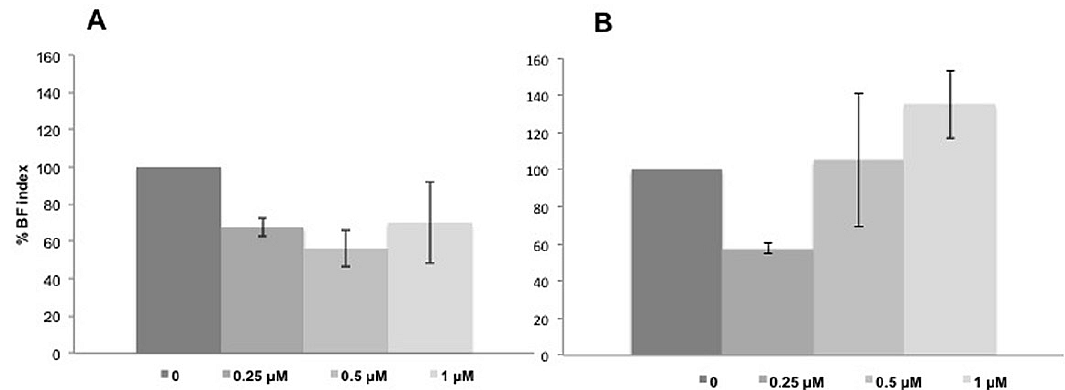
Figure 5. Biofilm (BF) production of KpTs101 in the presence of sub-inhibitory concentrations of Bac7(1–35) ( A ); and BMAP-27 ( B ). The BF index in the presence of AMPs after 24 h incubation was reported as percentage with respect to the control. Results are the mean of three independent experiments ± SD.